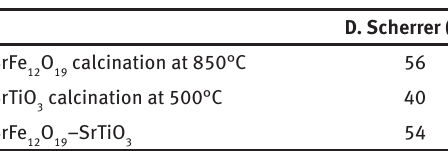
Table 1: Crystaline size for XRD paterns.